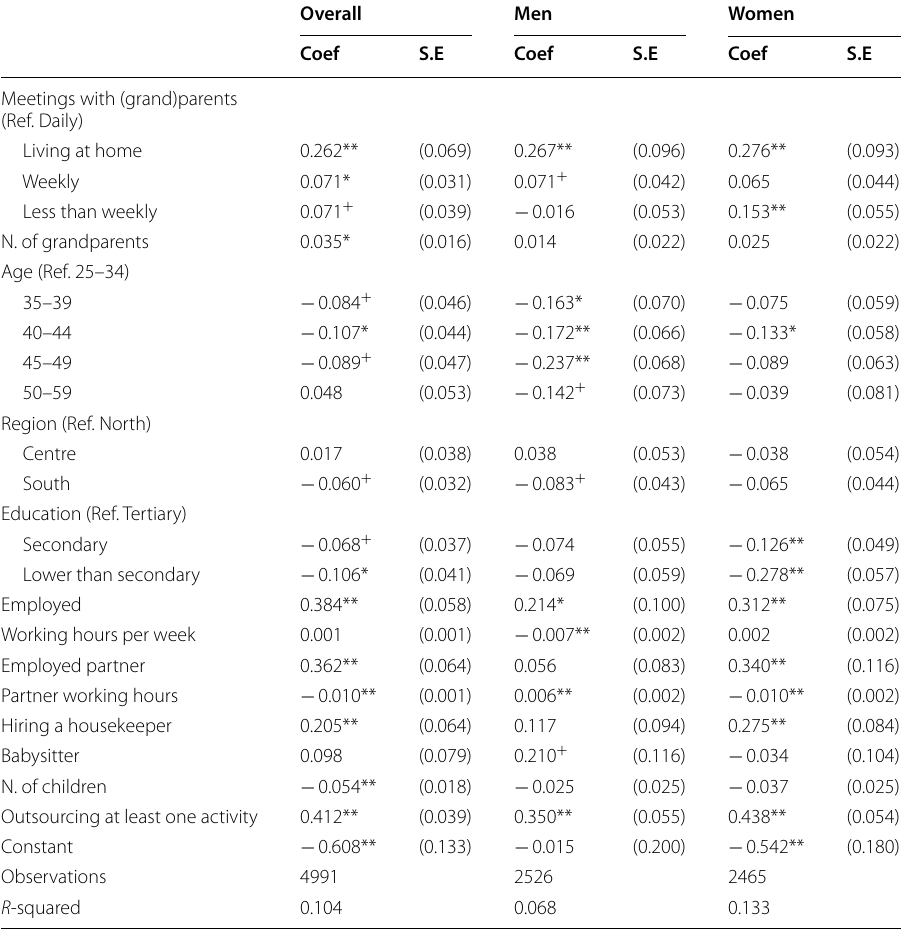
Table 5 Linear regression models on symmetry in the division of housework tasks ( Z